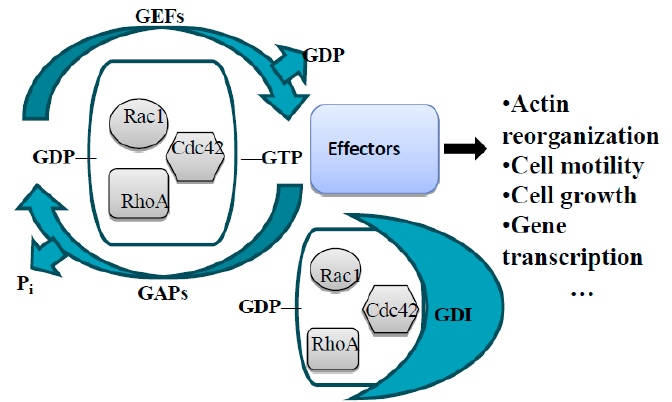
Figure 2. The mechanism of regulation of Rho GTPases. The Rho family of small GTPases shuttle between active, GTP-bound, and inactive, GDP-bound, states. This cycle is coordinated by three classes of regulatory proteins: (1) GEFs (Guanine nucleotide-exchange factors), which activate the small GTPases by performing the GDP to GTP exchange; (2) GAPs (GTPase-activating proteins), which inactivate the small GTPases by enhancing their intrinsic enzymatic activity to hydrolyze the GTP into GDP; and (3) GDIs (Guanine nucleotide-dissociation inhibitors), which sequester the small GTPases in their GDP-bound, inactive state in the cytosol.